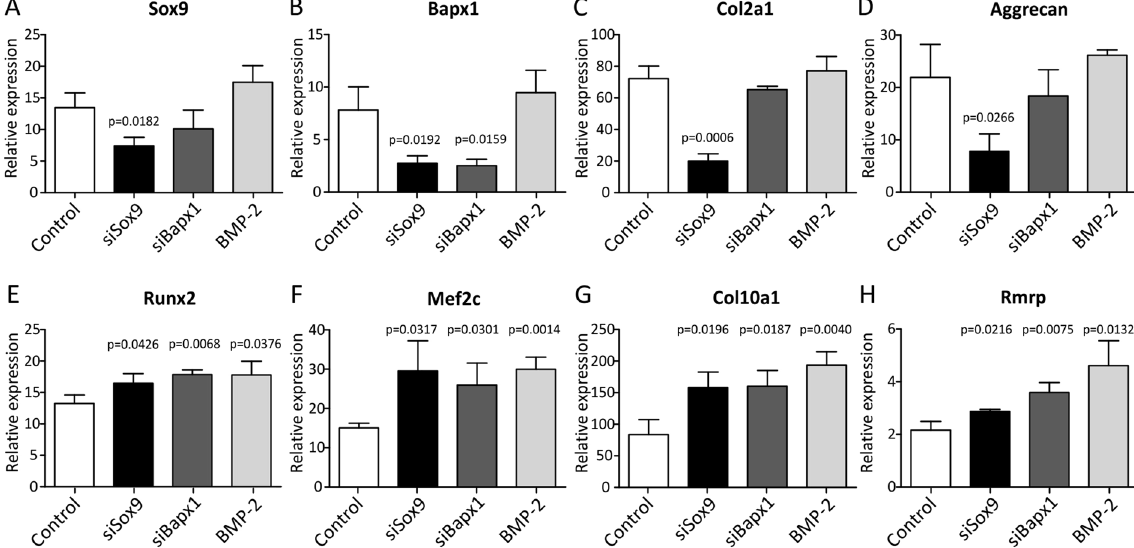
Figure 3. Rmrp RNA expression increases with ATDC5 hypertrophic differentiation. ATDC5 cells were transfected with 100 nM siRNA duplexes targeting Sox9 or Bapx1 gene expression on day -1, day 2, and day 5 during chondrogenic differentiation. A scrambled siRNA duplex purchased from Eurogentec was used as control condition for both Sox9 or Bapx1 knockdown. In addition, ATDC5 cells transfected with the scrambled siRNA were exposed to 30 ng/ml BMP-2 from the start of differentiation (cells from the BMP-2 condition were also transfected with the negative control scrambled siRNA in order to make all three interventions ( Sox9 knockdown, Bapx1 knockdown and exposure to BMP-2) technically comparable to the same control). RNA was isolated from these cultures at day 10 in differentiation. Gene expression of Sox9 ( A ), Bapx1 ( B ), Col2a1 ( C ), Aggrecan ( D ), Runx2 ( E ), Mef2c ( F ), Col10a1 ( G ) and Rmrp RNA ( H ) was determined by RT-qPCR. Gene expression is depicted as fold induction relative to t = 0. Data was normalized to β -actin expression and represents the average values of 3 biological replicates plus standard deviation. For statistical evaluation an independent samples t-test was performed relative to control using Graphpad Prism 5. p-values are indicated. Experiment was performed three times with presented graphs being representative